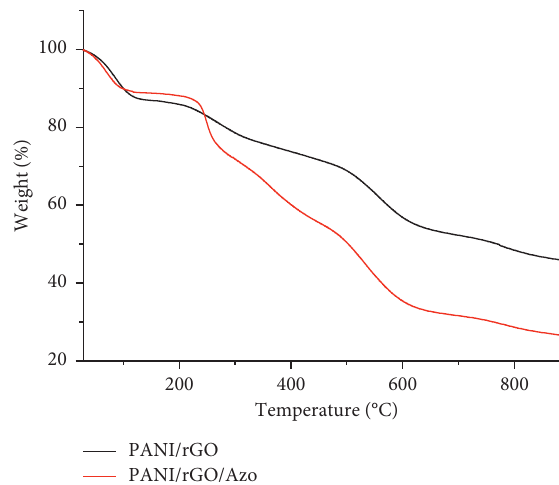
Figure 6: TGA curves of PANI/GO and PANI/GO/Azo compositions.